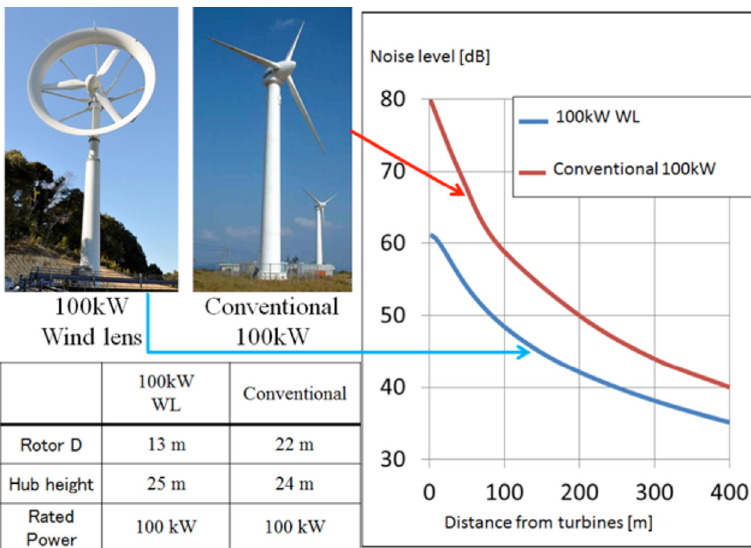
Fig. 1. Wind lens turbine, the mechanism and its performance.